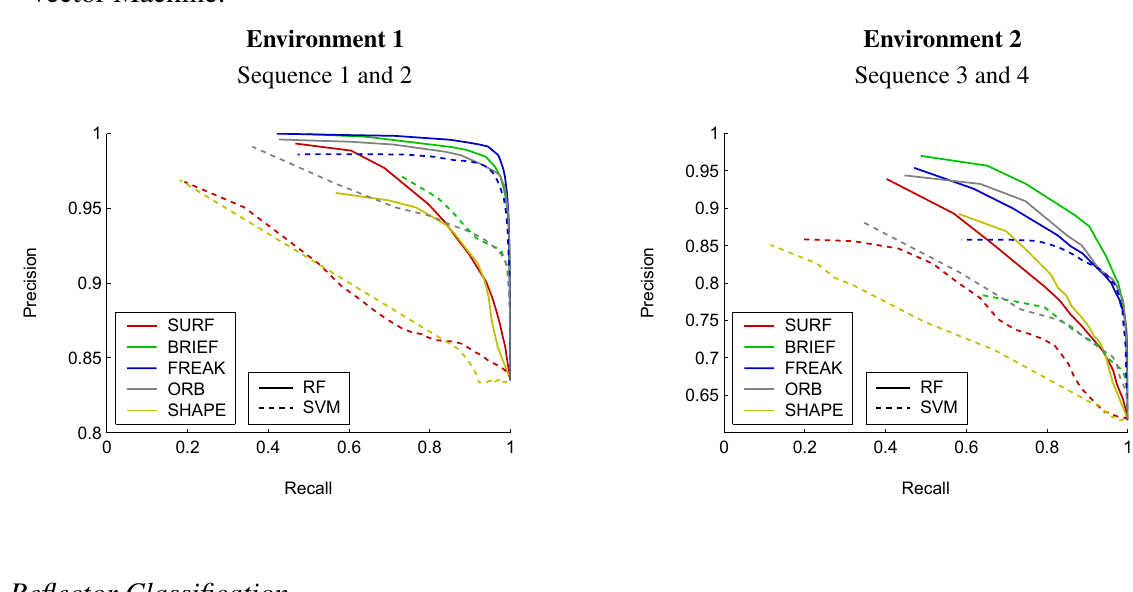
Figure 11. Precision-recall curves showing the classification of individual blobs into reflectors of a safety garment and other reflectors. The curves indicate classification performance as obtained using the state-of-the-art image feature descriptors SURF, BRIEF, FREAK, and ORB in combination with two popular classifier models, a Random Forest (RF) and a Support Vector Machine (SVM). Solid lines represent the output of a Random Forest classifier while the dashed line indicates classification results obtained using a Support Vector